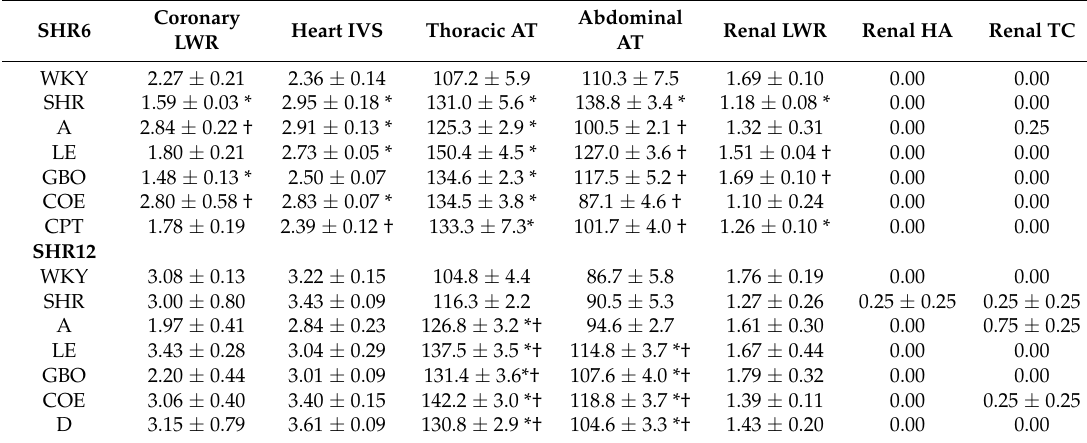
Table 6. Histopathological results of the heart, aorta, and